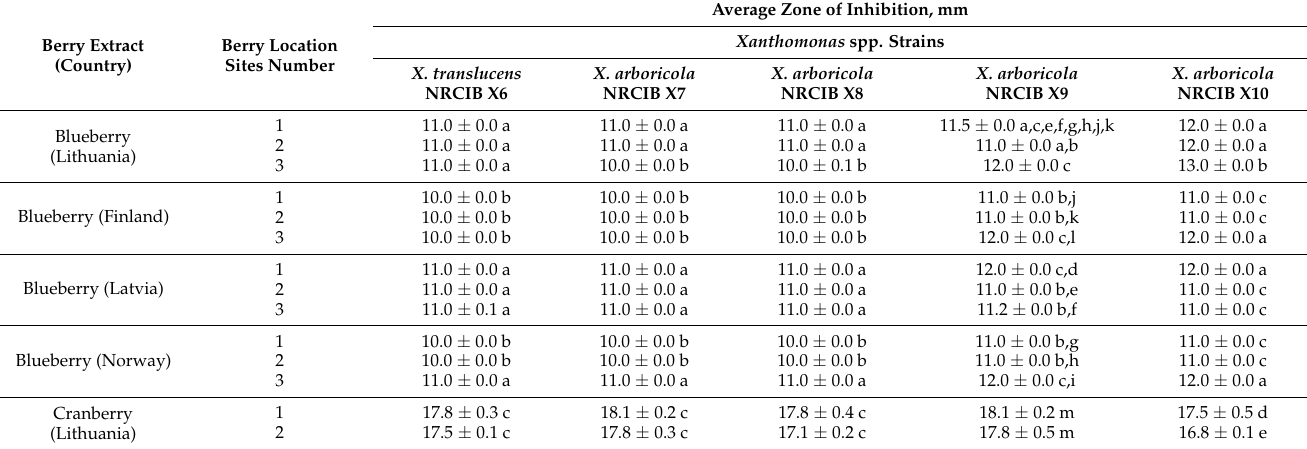
Table 4 Antibacterial activity of blueberry and cranberry aqueous extracts against Xanthomonas spp. strains.